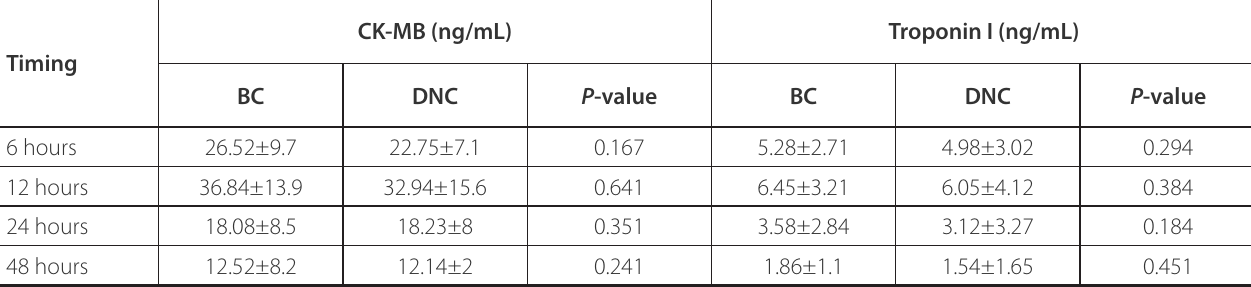
Table 4 . Cardiac